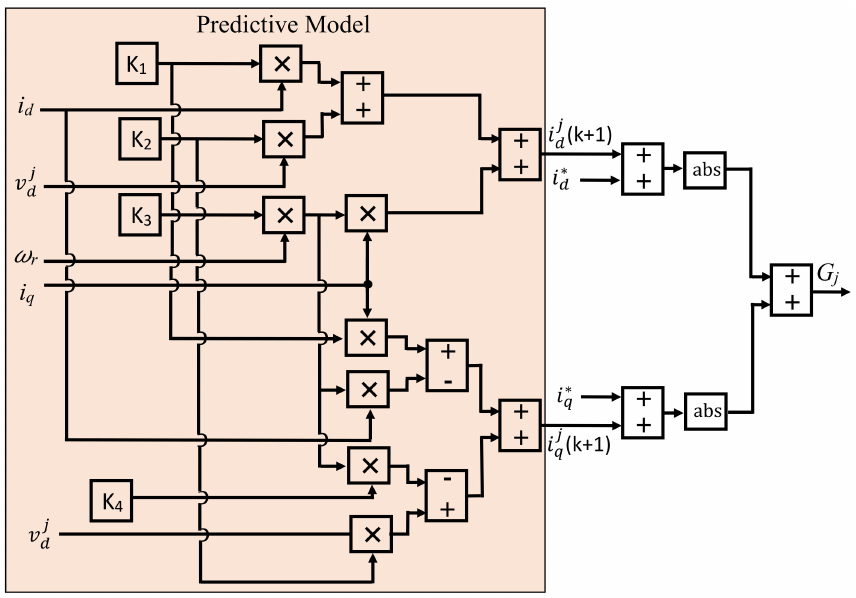
Figure 4. XSG-based design of the current prediction and cost function.